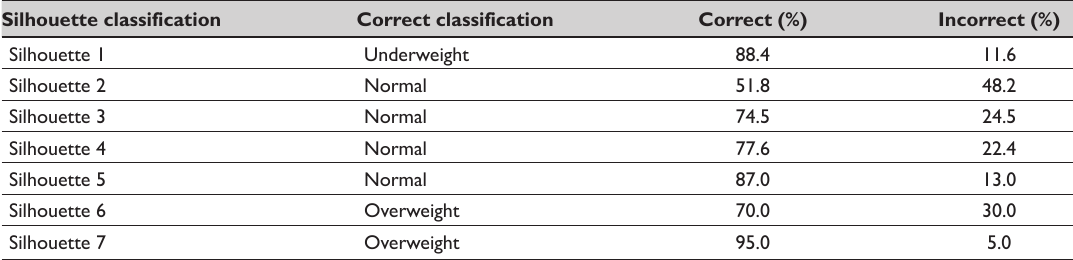
Table 2: Silhouette classification by mothers